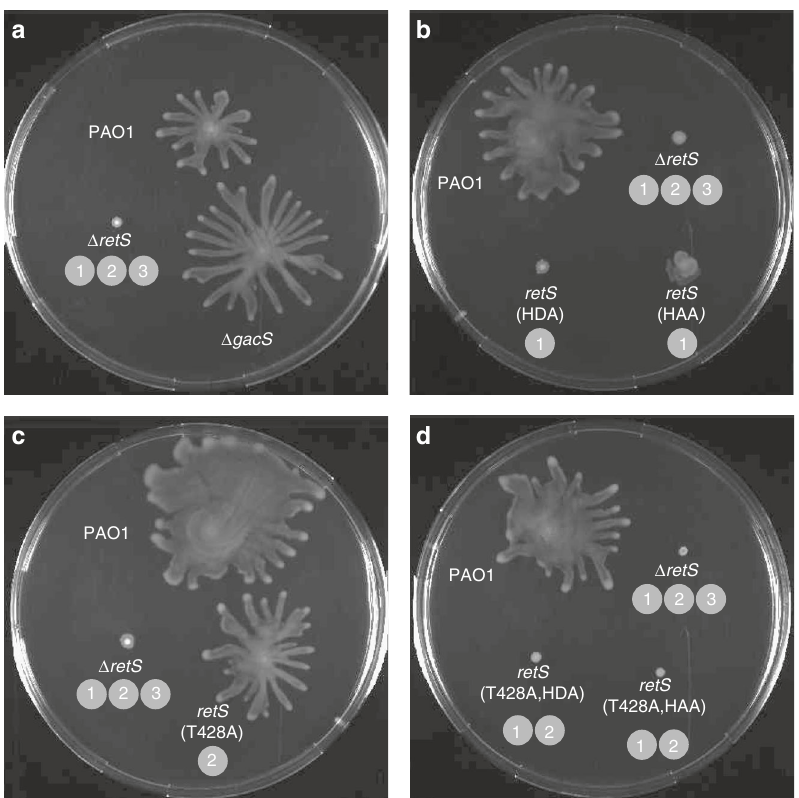
Fig. 3 Mechanism 1 is required for swarming motility. a – d Representative images of the swarming of the wild-type PAO1 strain and its mutant derivatives. Experiments were repeated three times. The mechanisms disabled in each mutant strain are indicated in